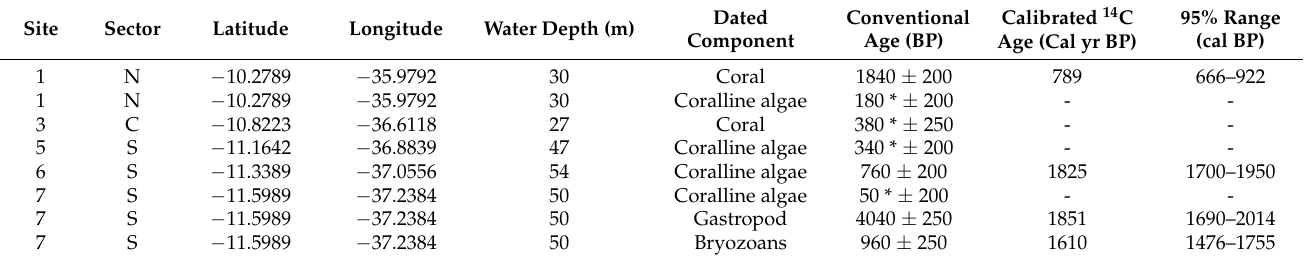
Figure 7. Radiocarbon dated samples collected in different sectors of the SEAL Basin. The yellow squares indicate location of the dated fossils in the sample: North sector: ( A ) Coral from site 1 (30 m depth); ( B ) Coralline algae from site 1 (30 m depth); Central sector: ( C ) Coral from site 3 (27 m depth); South sector: ( D ) Coralline algae from site 5 (47 m depth); ( E ) Coralline algae from site 6 (54 m depth); ( F ) Coralline algae from site 7 (50 m depth); ( G ) Gastropod shell from site 7 (50 m depth); ( H ) Bryozoan from site 7 (50 m depth). Scale bars = 2 cm. Table 4. Radiocarbon age of different components in rhodoliths collected at different sites from 3 sectors (N, North; C, Central; and S, South) of the SEAL Basin. Coordinates are in SIRGAS 2000 Datum. * Values < 433 yr BP cannot be calibrated at the curve Marine20; BP = before